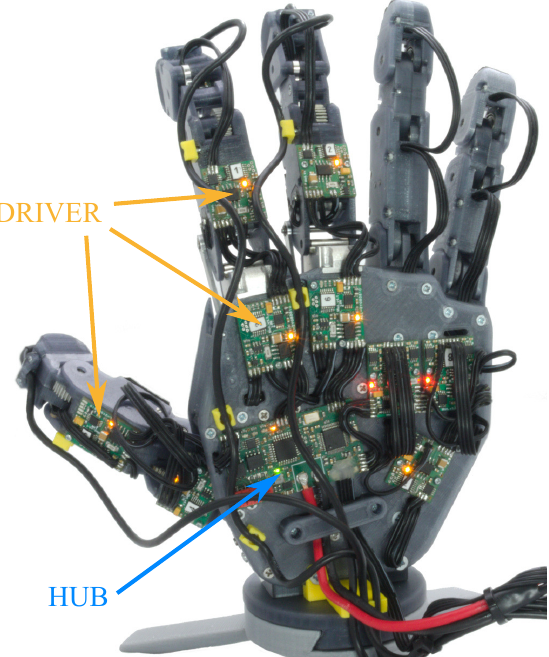
Figure 10. PUT-Hand with visible controller electronics; not all DRIVER modules are